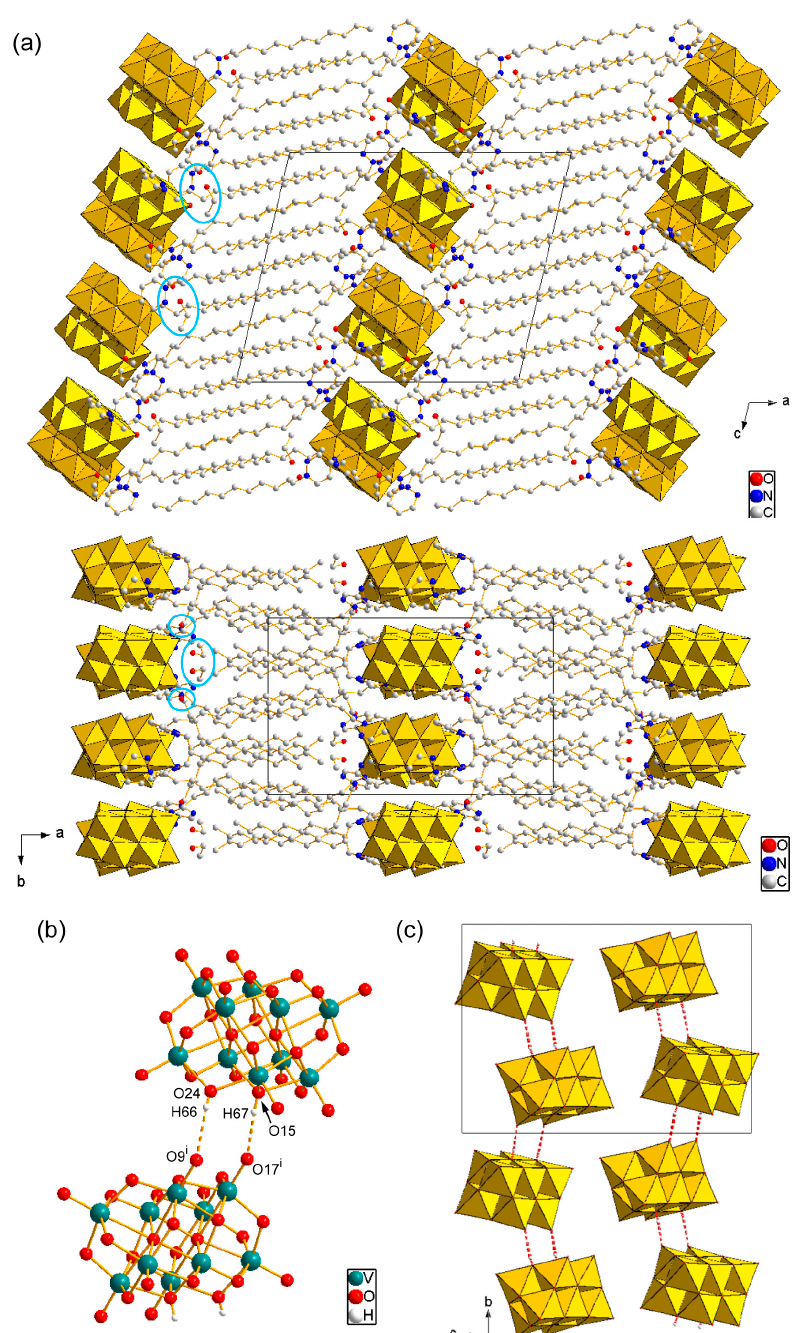
Figure 4. Crystal structure of C 12 pda-V 10 (C: gray, N: blue, O: red, H: white); ( a ) packing diagram along b axis (upper) and c axis (lower). V 10 anions in polyhedral representation. H atoms of C 12 pda and ethanol of crystallization are omitted for clarity. Some solvent molecules are highlighted; ( b ) molecular structure of diprotonated V 10 anion. Another V 10 anion is generated by the symmetry operation (1 − x , − 0.5 + y , 0.5 − z ). Symmetry code: ( i ) 1 − x , − 0.5 + y , 0.5 − z ; ( c ) molecular arrangements in the inorganic layers. V 10 anions in polyhedral representation. The short contacts derived from O-H···O hydrogen bonds are represented in red broken lines. The C 12 pda cations and solvents of crystallization are omitted for clarity.